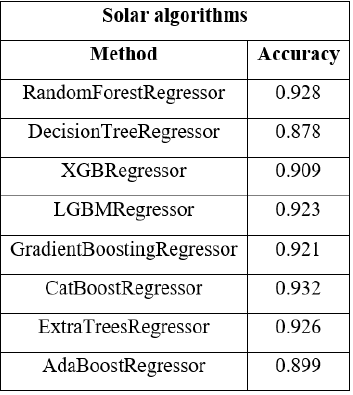
Figure 6. Scoring algorithms ml